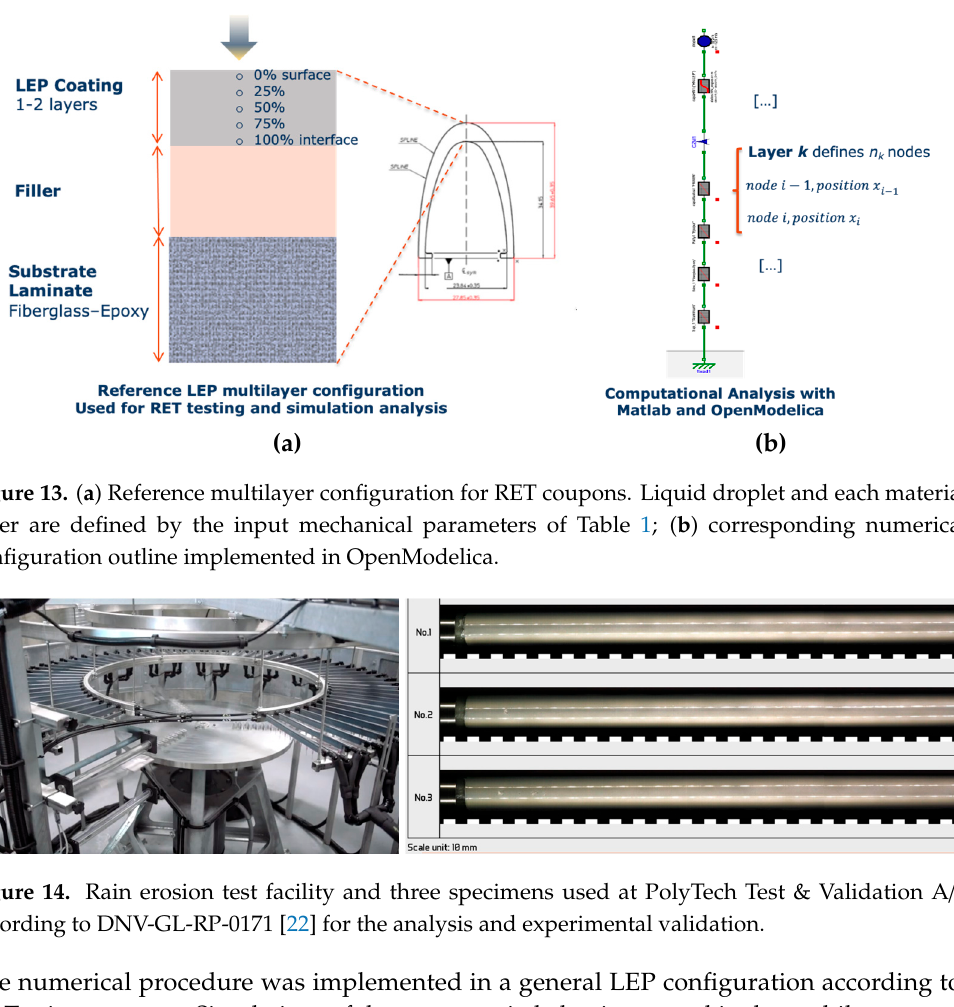
Figure 12. LEP configuration considering viscoelastic material models, multilayer and 1D droplet impact event.